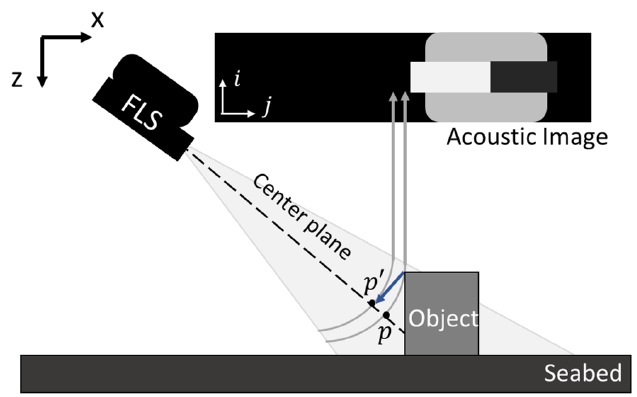
Figure 4. Orthographic projection approximation. p is the original point of P mapped by sonar geometry, and p (cid:48) is the projected point of P on the center plane of the acoustic beam.